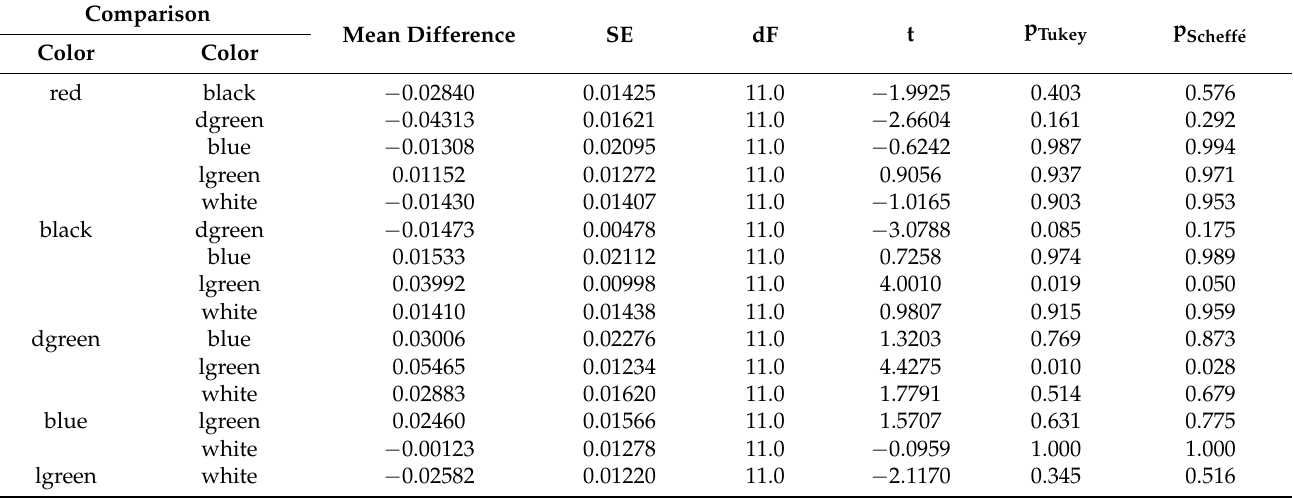
Table 4. Post Hoc